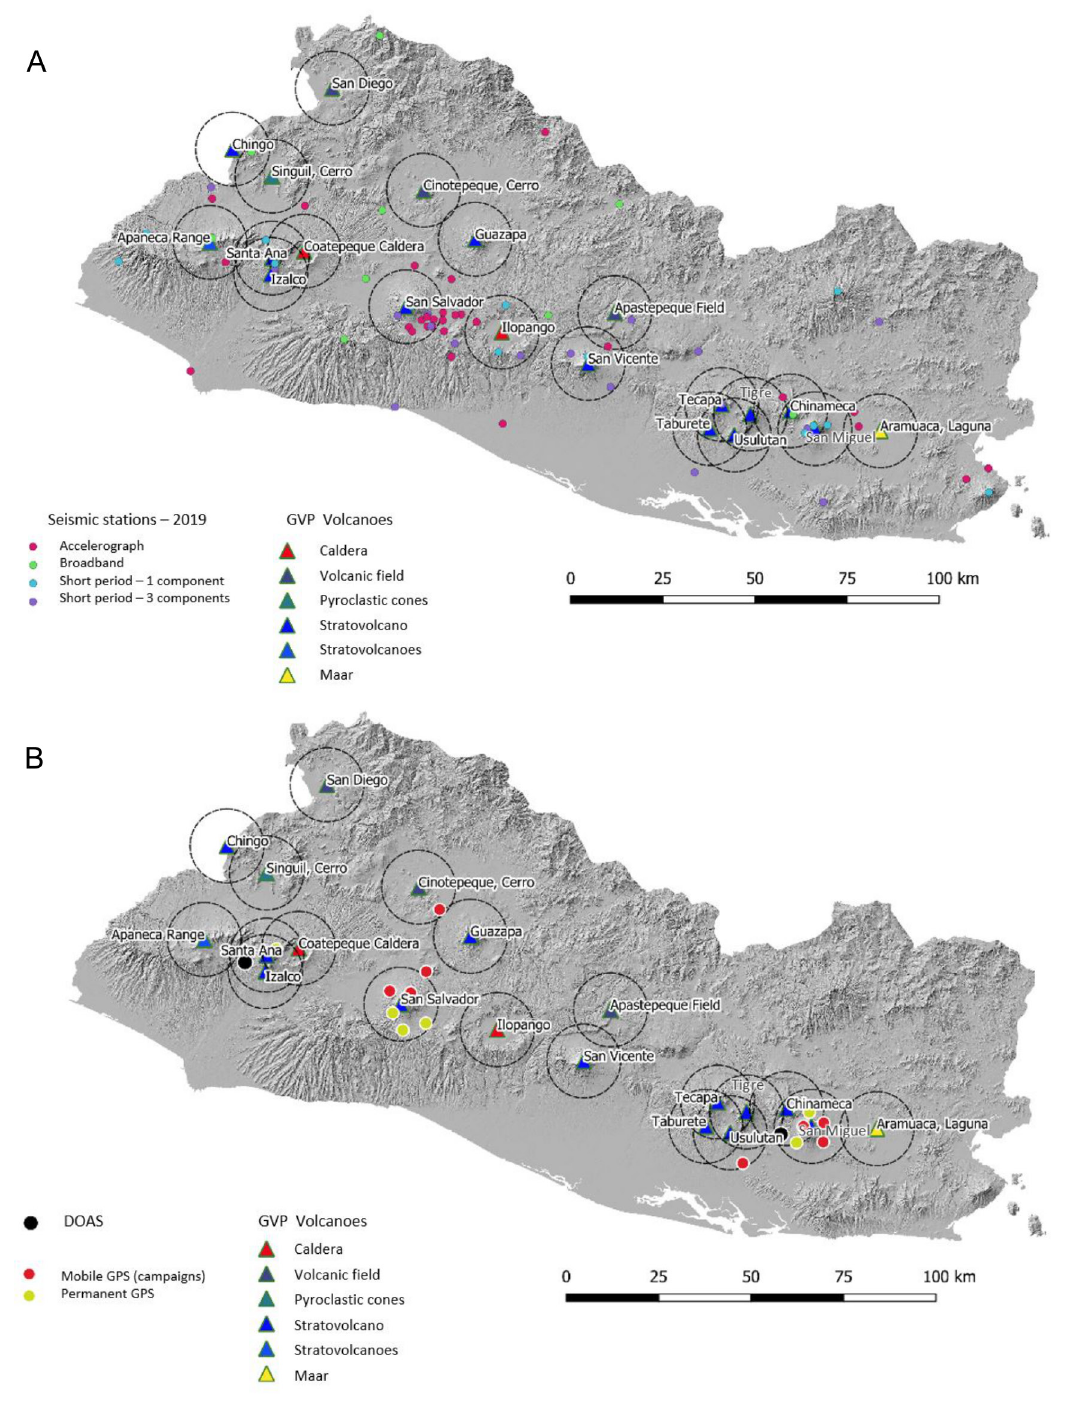
Figure 2: Maps of the monitoring network. [A] Seismic stations, [B] DOAS and GPS stations [MARN 2019a].